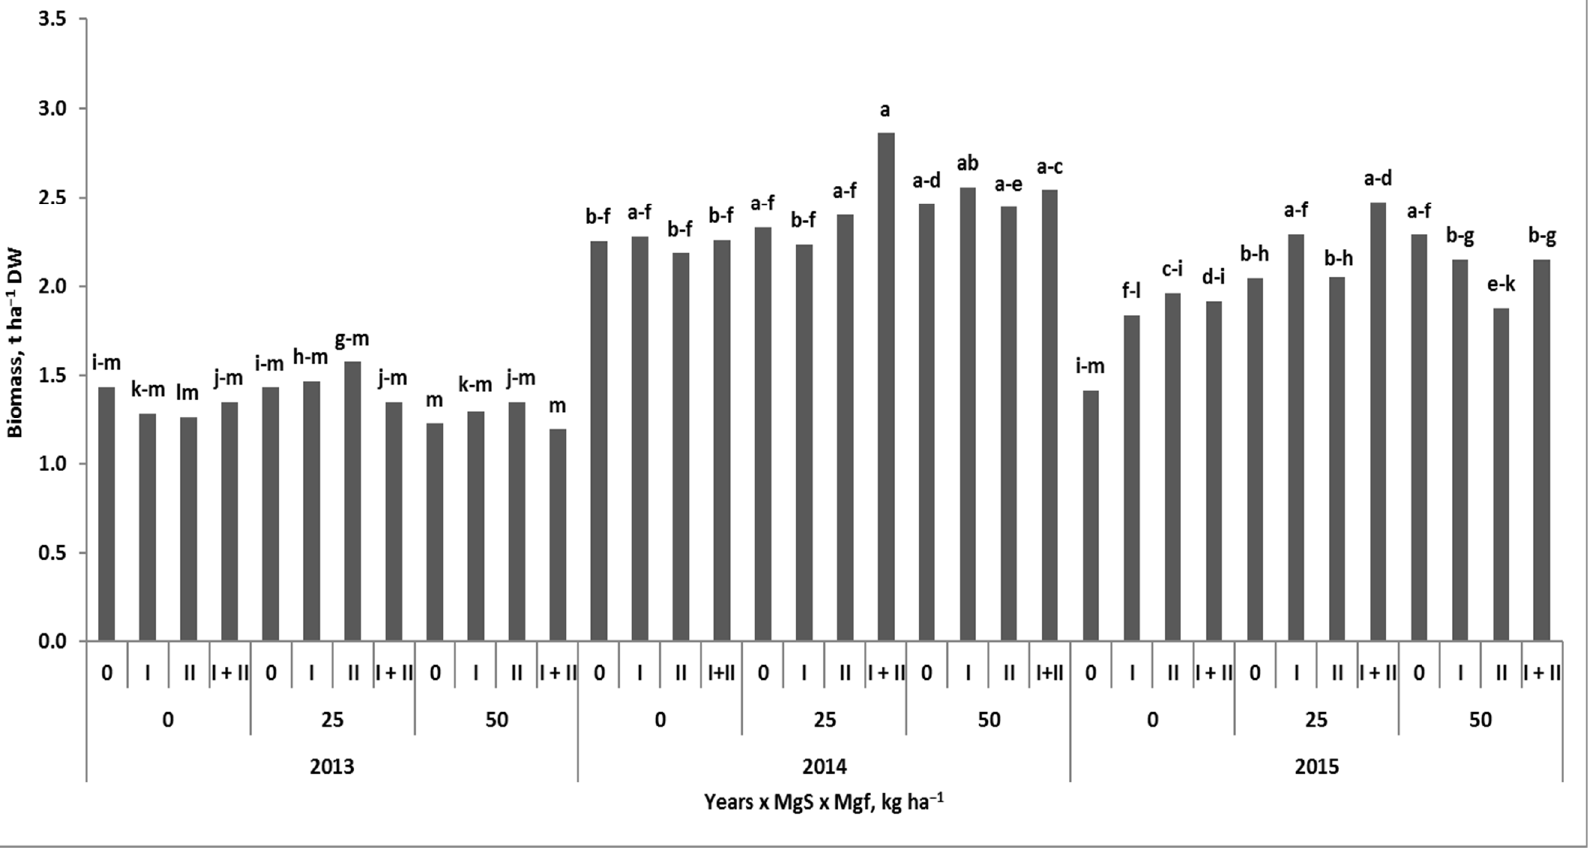
Figure 3. Effect of magnesium fertilization systems on the background of years on the leaf biomass of winter wheat at the BBCH 58 stage. Similar letters mean a lack of significant differences using Tukey’s test. Legend: Mgs, Mgf—soil and foliar Mg fertilization systems, respectively; I—BBCH 30; II—BBCH 49/50.